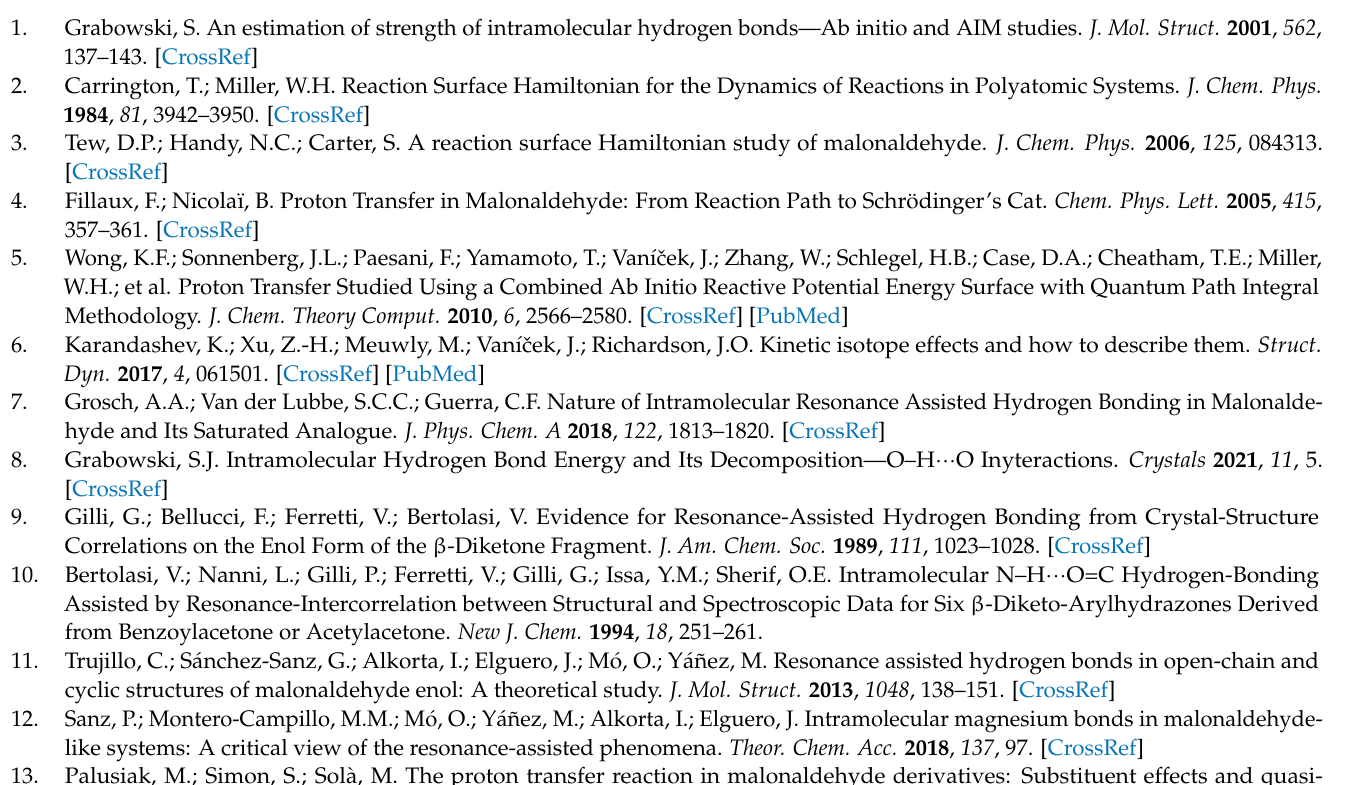
5. EOM-CCSD spin–spin coupling constants 2h J(O–O), 1h J(H–O), and 1 J(O–H) were computed for all equilibrium and transition structures. Plots of 2h J(O–O) versus the O–O distance, 1h J(H–O) versus the H–O distance across the hydrogen bond, and 1 J(O–H) versus the covalent O–H bond distance of 1 exhibit a second-order dependence of the coupling constant on the corresponding distance, with very high correlation